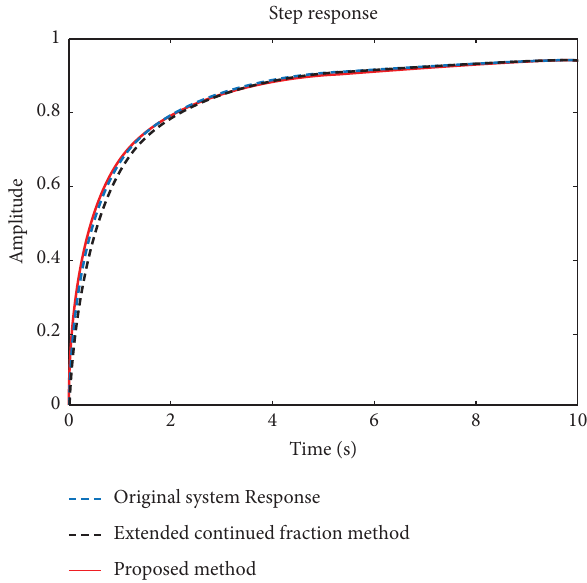
Figure 2: Comparison of the step response among the models